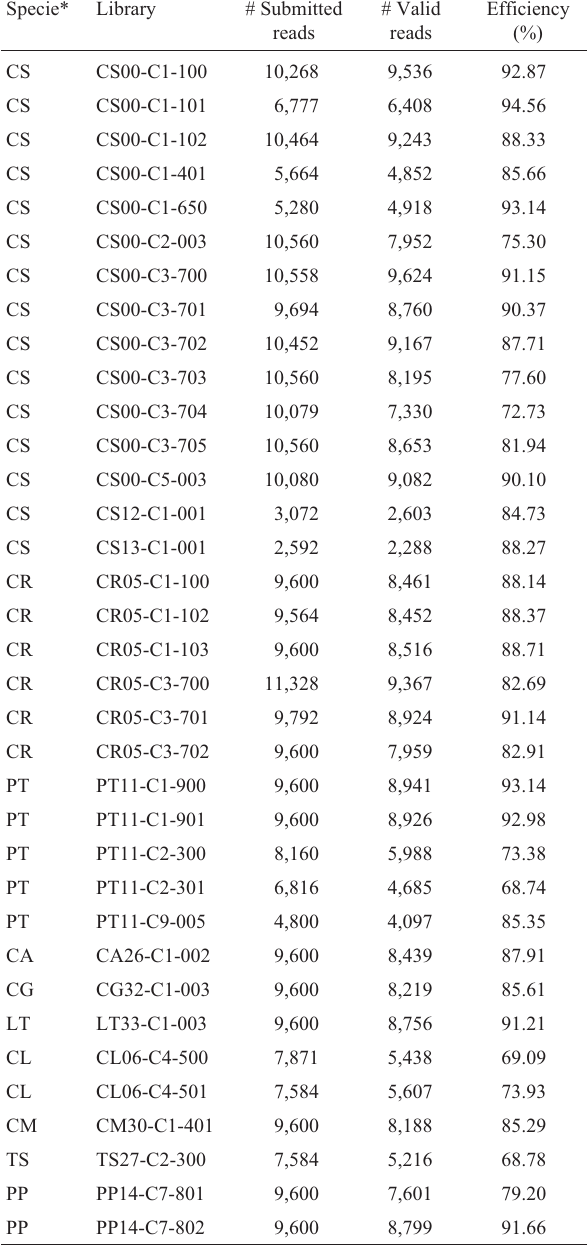
Table 2 - General data obtained from each CitEST